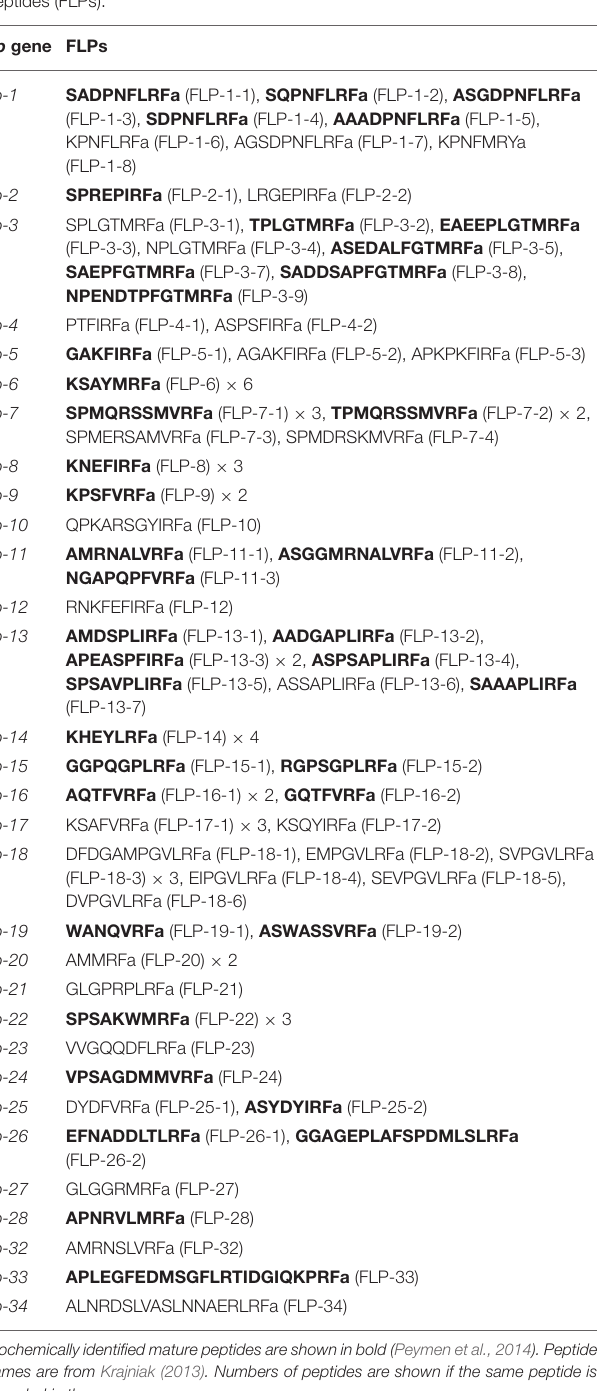
TABLE 2 | C. elegans fmrfamide-like peptide (flp) genes and FMRFamide-like peptides